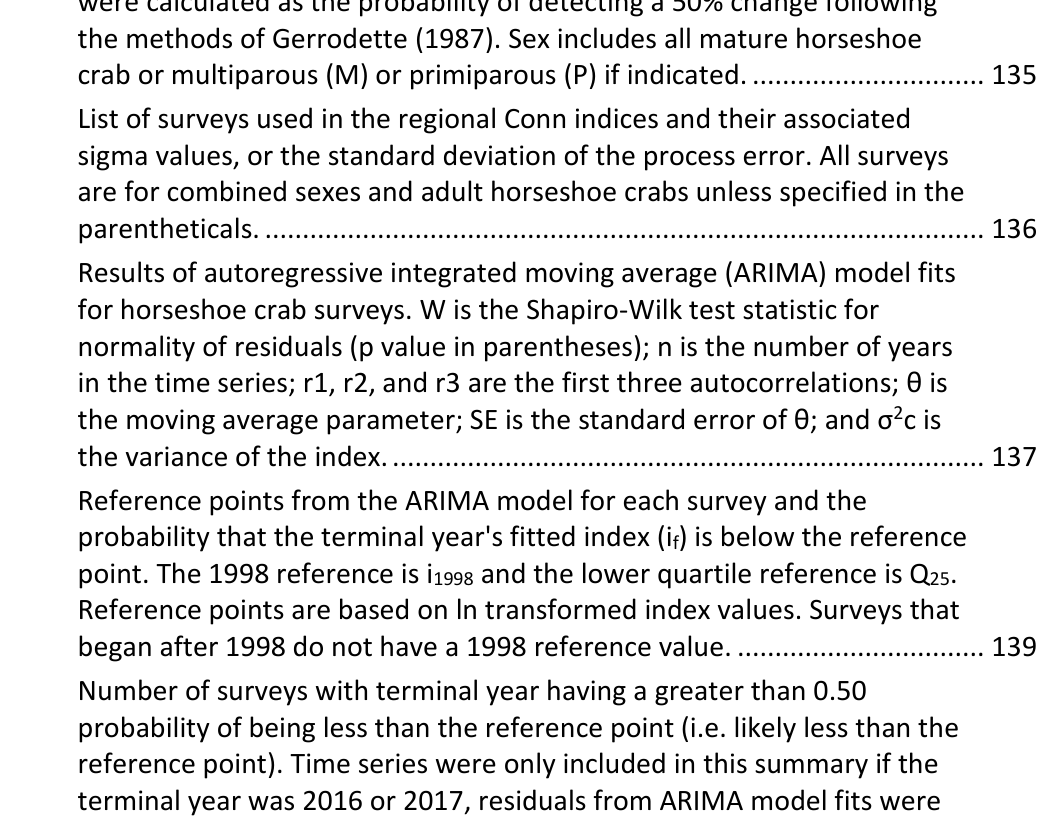
Scenarios of F simulated by the operating model to generate data sets used in a surplus production model and a catch survey model. Fishing mortality varied annually according to a uniform distribution with bounds Catch multiple survey analysis base model inputs. *Values shown in The number of parameters estimated in the catch multiple survey analysis: median primiparous abundance (1); primiparous abundance for each year (16); catchability coefficients (2) for the Delaware and New Jersey surveys; and multiparous abundance for the start of the time Selected catch multiple survey analysis based model outputs: q=catchability coefficients; R=primiparous abundance; N=multiparous abundance; u=exploitation rate; Z= instantaneous total mortality rate; Mohn’s p statistic for total, multiparous, and primiparous abundance. ....... 2019 Horseshoe Crab Benchmark Stock Assessment Non-Confidential Report xi